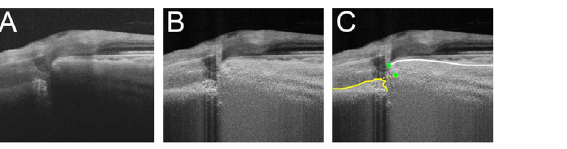
Fig. 3. ALID measurement in eyes with an acquired pit. A. SS-OCT image without labels. Note that the lamina cribrosa is disinserted from the adjacent sclera. B. SS-OCT image after adaptive compensation. C. ALI was defined using an imaginary extension line (yellow dashed line) in eyes with a pit.